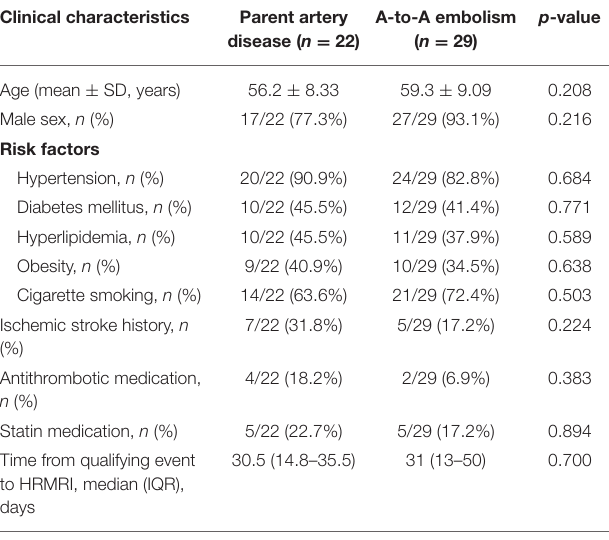
TABLE 1 | Baseline and plaque characteristics. Characteristics